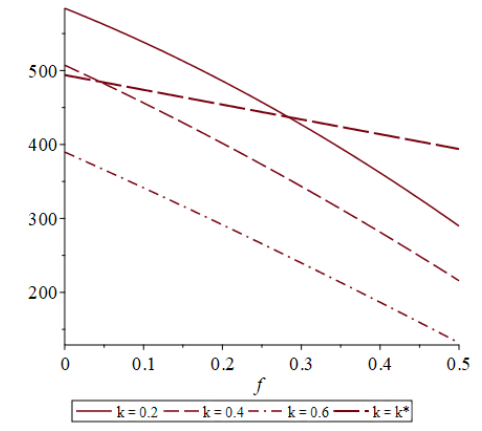
Figure 2. The relationship between the optimal allocation ratio and default